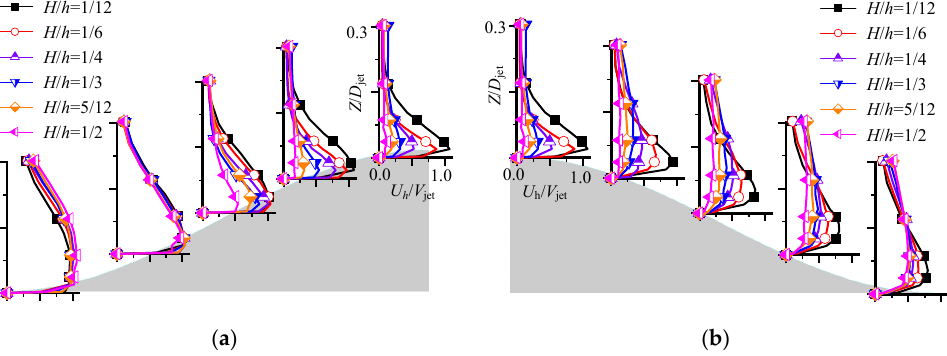
Figure 9. Profiles of horizontal wind velocity on 135°-ray ( a ) and 45°-ray ( b ) ridges ( L = 0.5 D jet , r h = 1.0 D jet ).